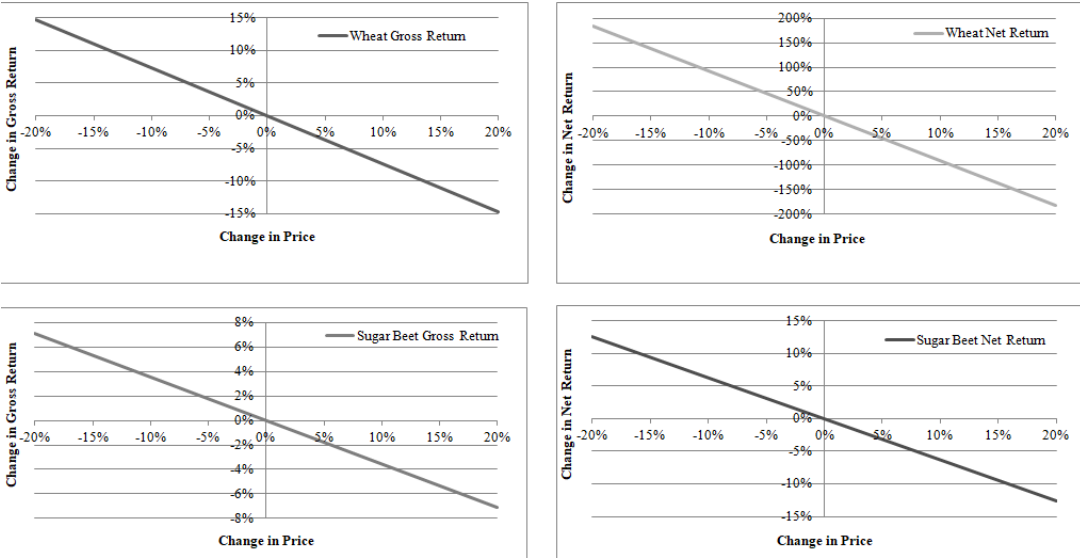
Figure 3. Changes in gross return and net return in wheat and sugar beet production depending on the change in the fertilizers’ prices.